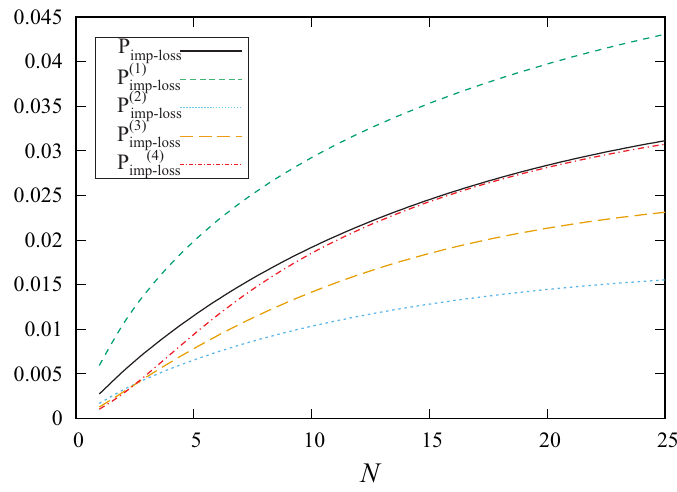
( r ) , r = 1, R , on the buffer capacity N . imp − loss